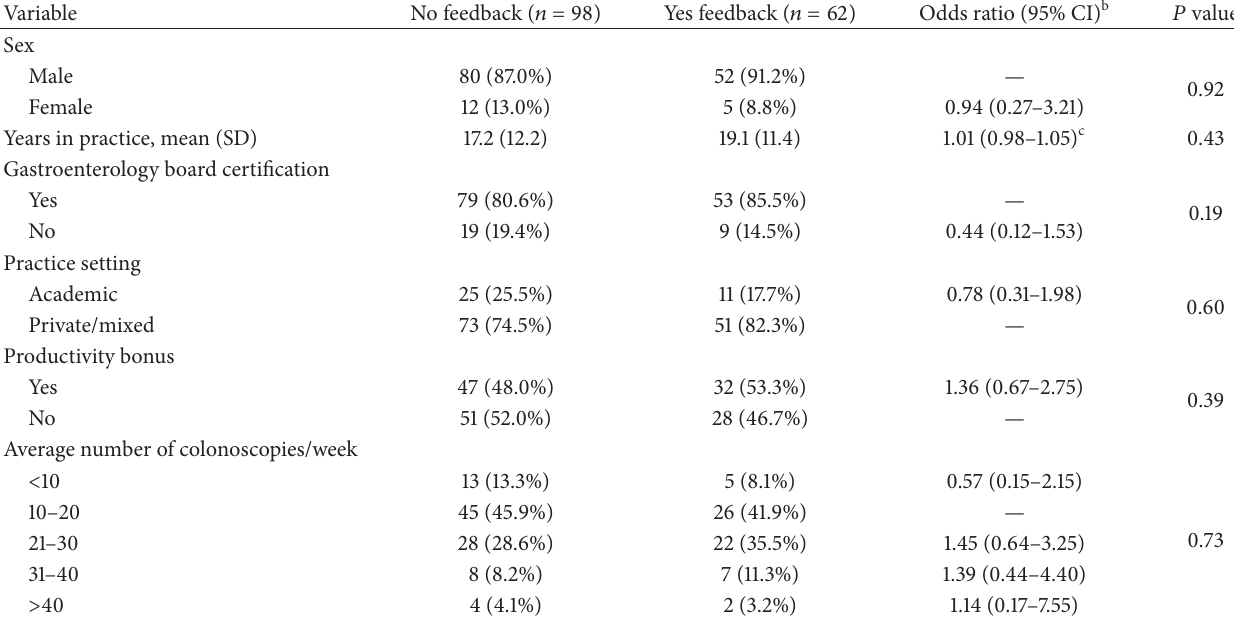
Table 2: Factors impacting the receipt of feedback regarding colonoscopy quality in multivariable analyses a .